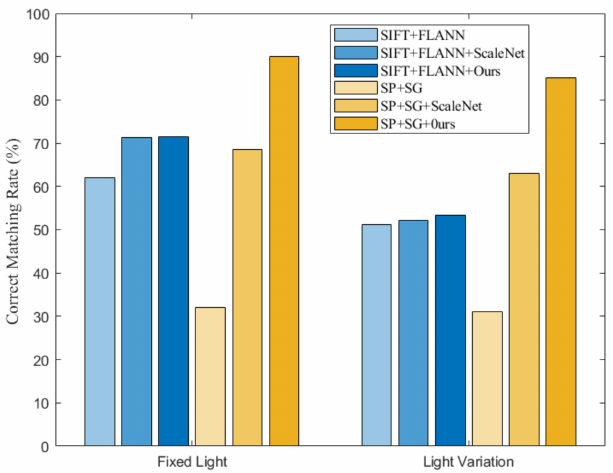
Figure 11. The correct matching rates in the FixedLight dataset and VariableLight